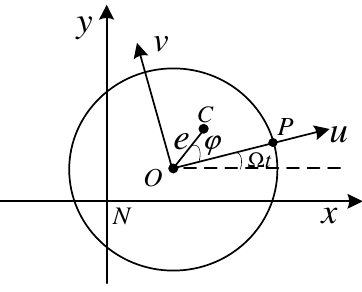
Figure 3. MLR’s rotation center, geometric center and mass center in ground and rotor-fixed reference